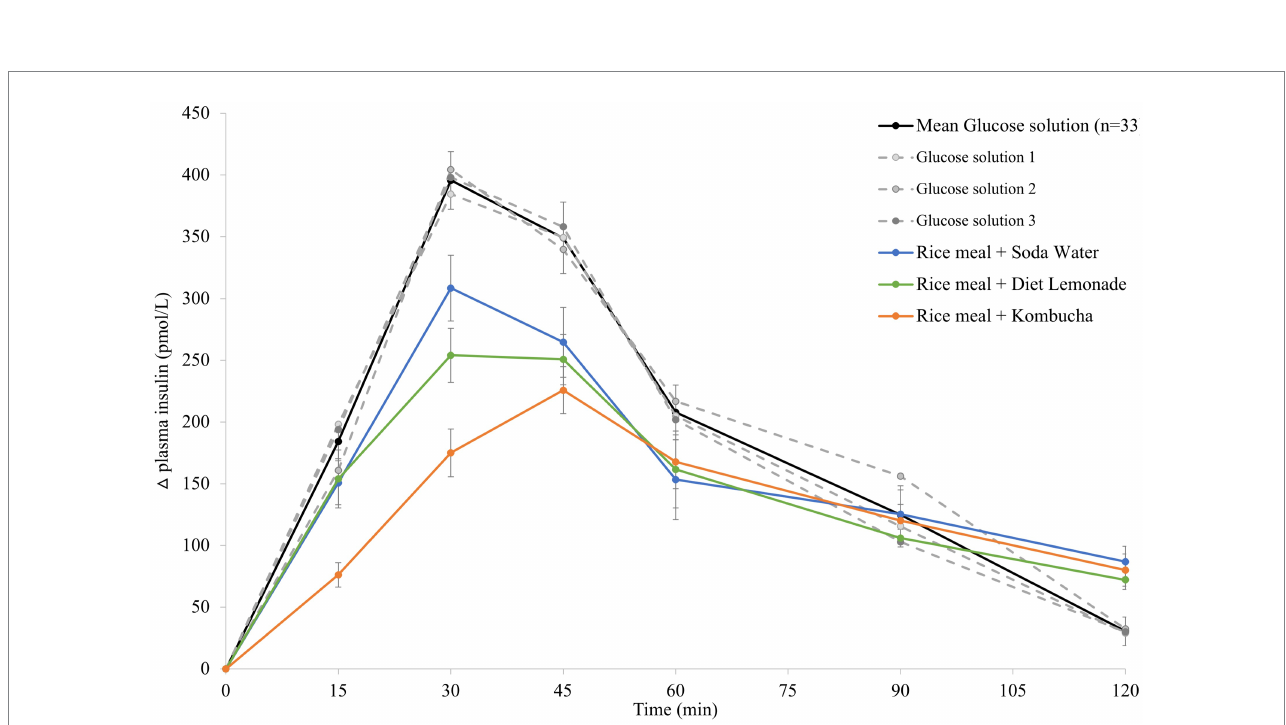
FIGURE 2 Postprandial insulin response after test meals. Mean 120 min plasma insulin response curves in 11 healthy participants for the reference glucose solution and the three Jasmine rice-based test meals containing different beverages, shown as the change in plasma insulin from the fasting baseline level. Data are shown as mean ± standard error of the mean (SEM), n = 33 for the three repeated glucose solution tests (shown in black, with the three individual glucose solution tests ( n = 11) shown in grey dotted lines), n = 11 for each of the three treatments: soda water meal (shown in blue), diet lemonade soft drink meal (shown in green) and kombucha meal (shown in